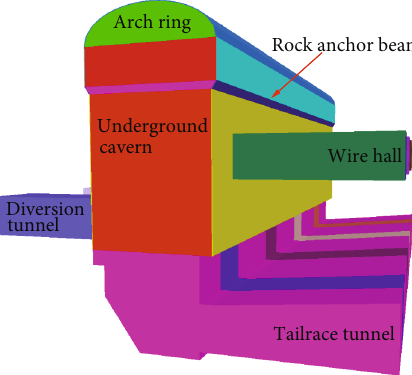
Figure 6: Three-dimensional model of the underground